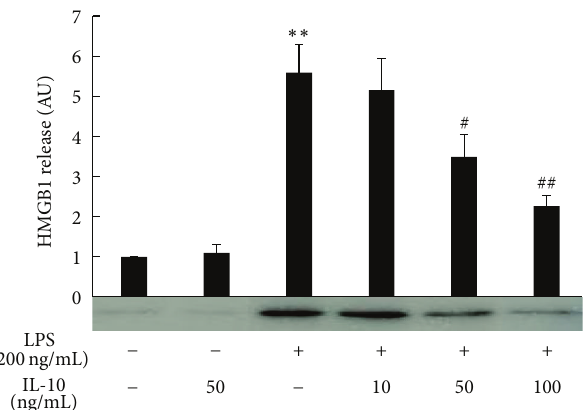
Figure 2: Effect of recombinant IL-10 on LPS-induced HMGB1 release. Raw 264 cells were cultured as described in Figure 1 legend and were treated with IL-10 for 18 h, then stimulated with LPS (200 ng/mL) for another 24 h. Culture medium was collected and analyzed by HMGB1 western blotting followed by quantification of the intensity of the chemiluminescent HMGB1 band. The results are expressed as means ± SE of three independent experiments ( ∗∗ 𝑝 < 0.01 significance compared with control; ## 𝑝 < 0.01 and # 𝑝 < 0.05 significance compared with LPS treated